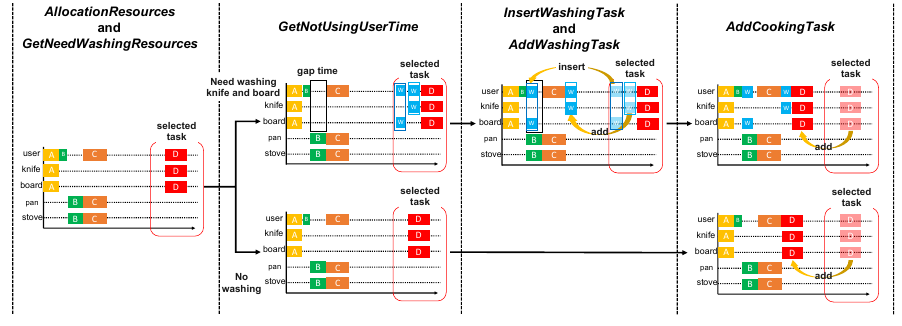
Figure 5. Example of how Algorithm 2